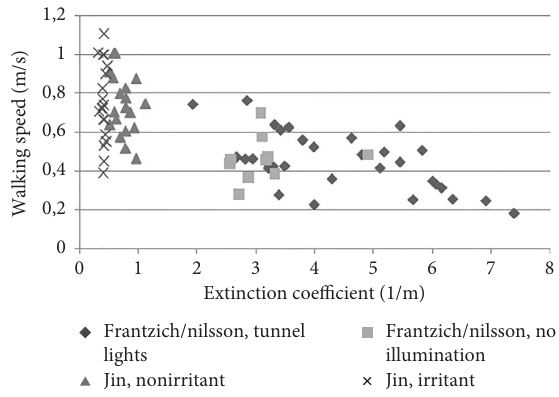
Figure 10: Walking speed of humans in smoky area, for switched- on and switched-off illumination